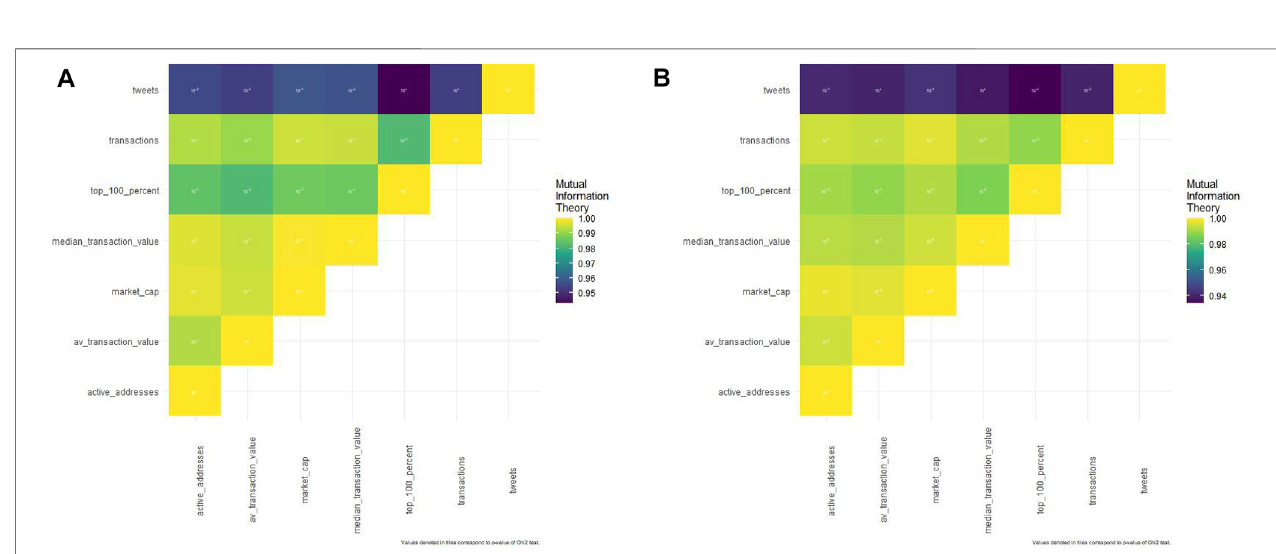
FIGURE 2 | (A) . Mutual information theory matrix concerning Litecoin. (B). Mutual information theory matrix concerning Dogecoin.